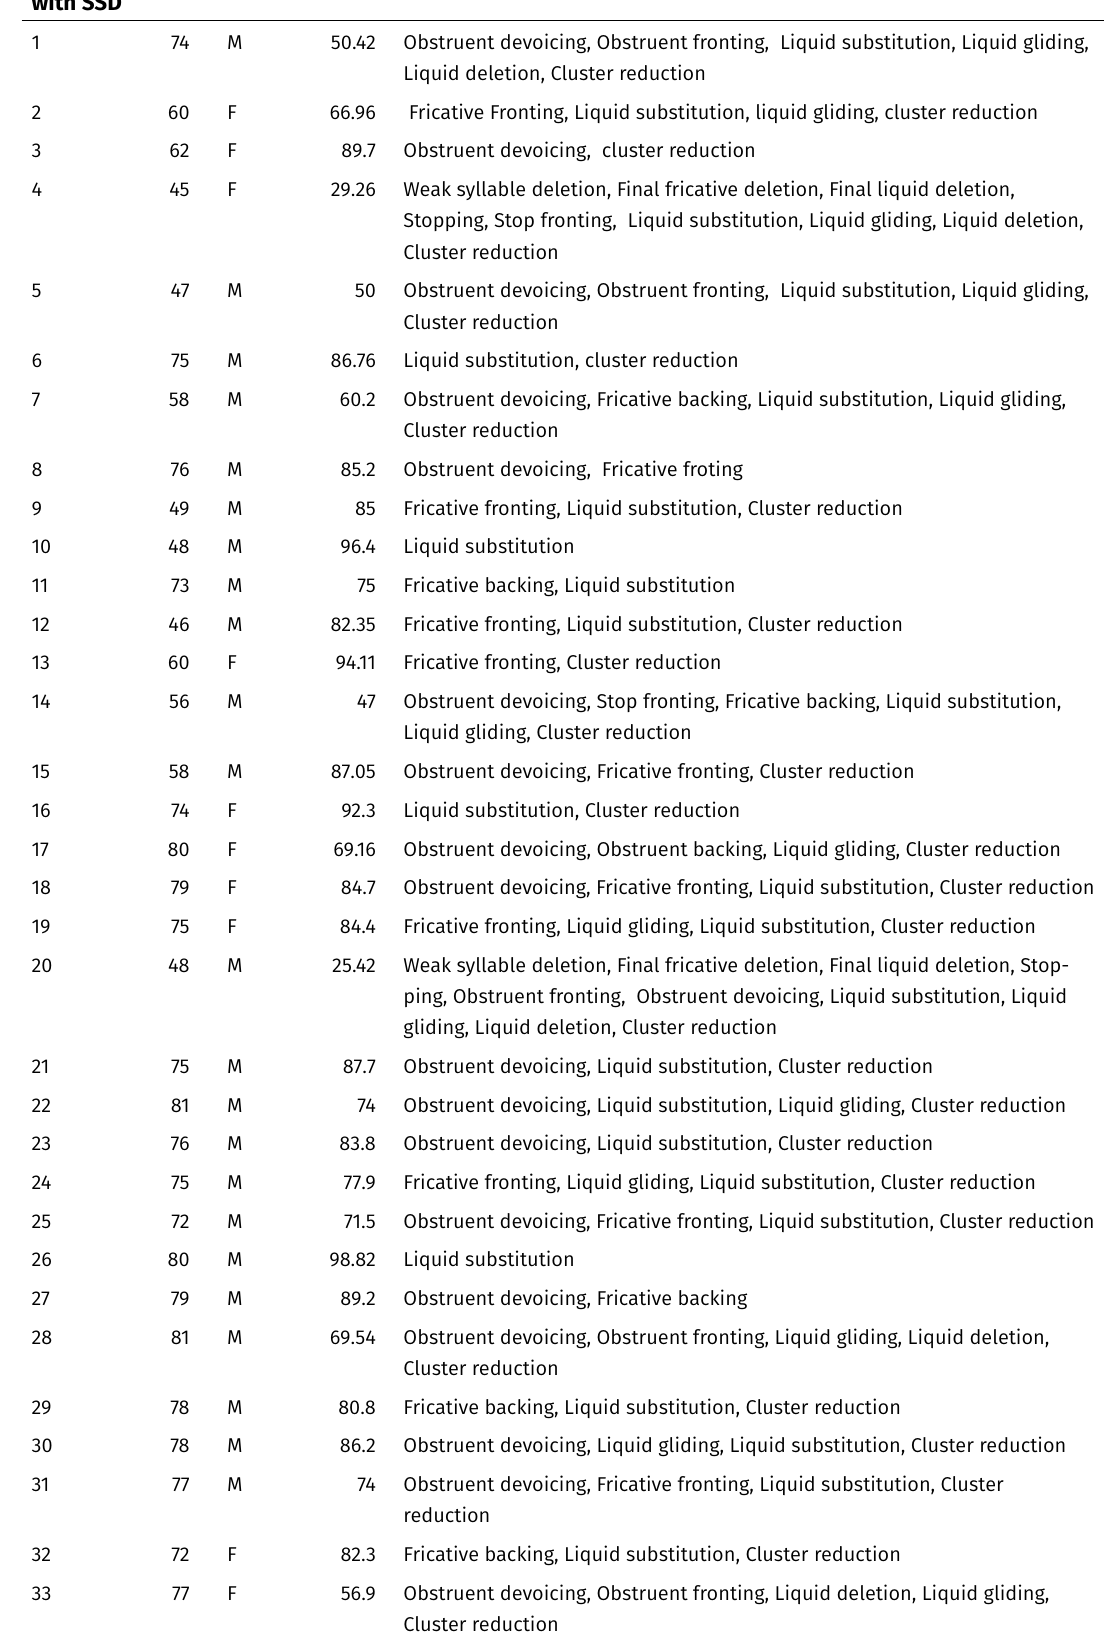
Chart 1: Characterization of the participants (n =